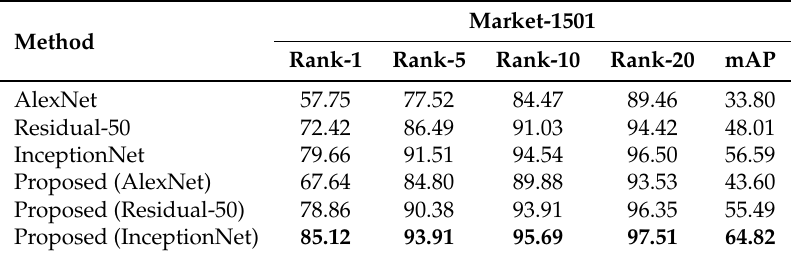
Table 1. Comparison with the three base networks, AlexNet, Residual-50 and InceptionNet on Market-1501 (by adopting the proposed DJL-S structure) in terms of identification accuracy (%) and mAP (%).